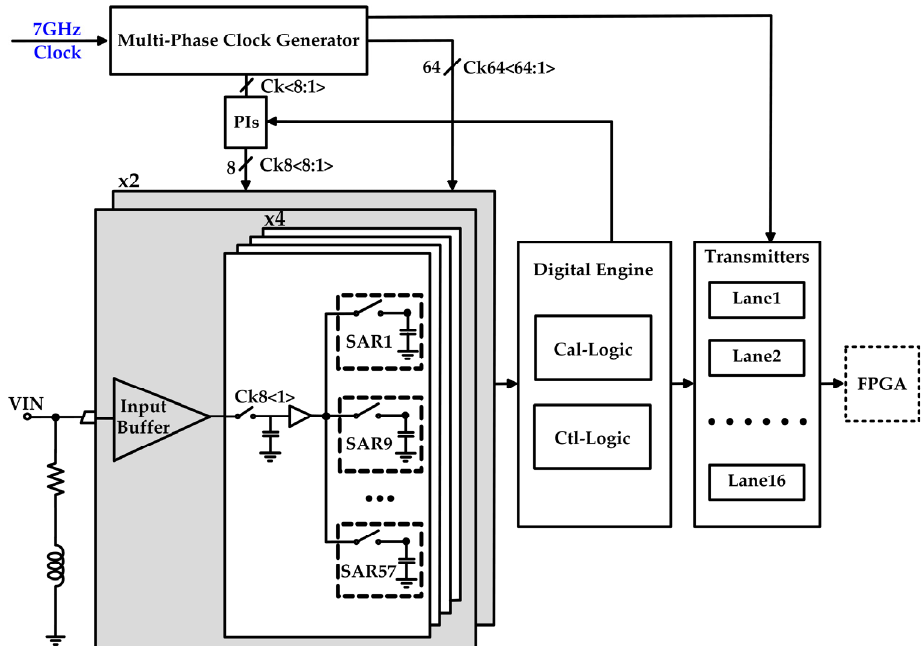
Figure 1. Overall architecture of the proposed 56 GS/s time-interleaved ADC.